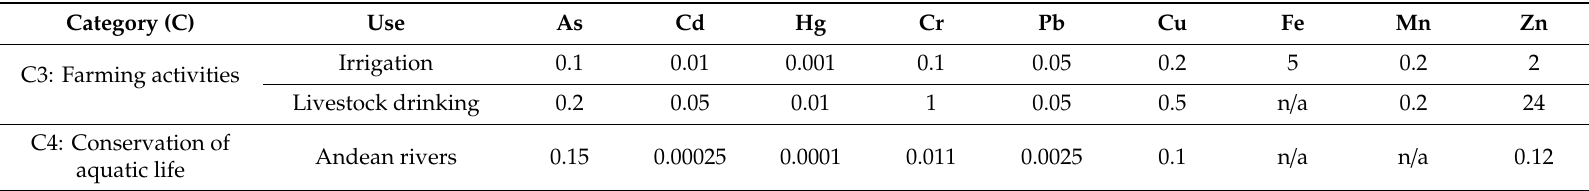
Table A5. Environmental Quality Standards (EQS) (mg L − 1 ) established by the Peruvian Ministry of Environment in